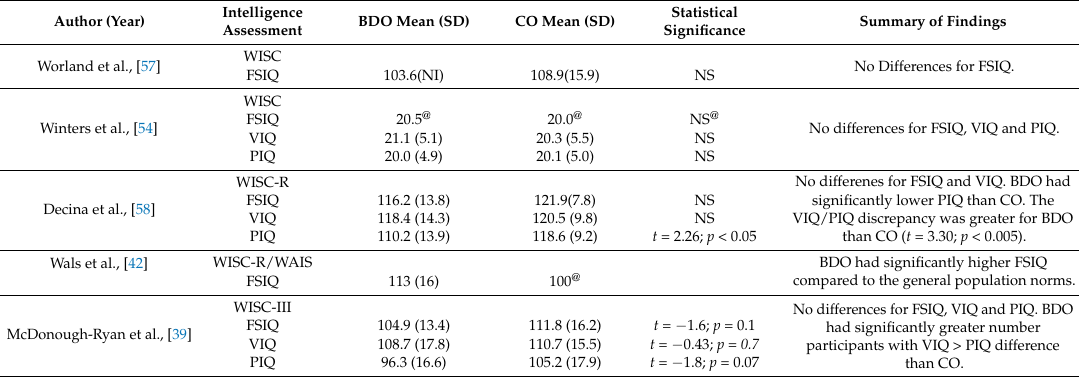
Table 2. Studies of Bipolar Offspring—Results of